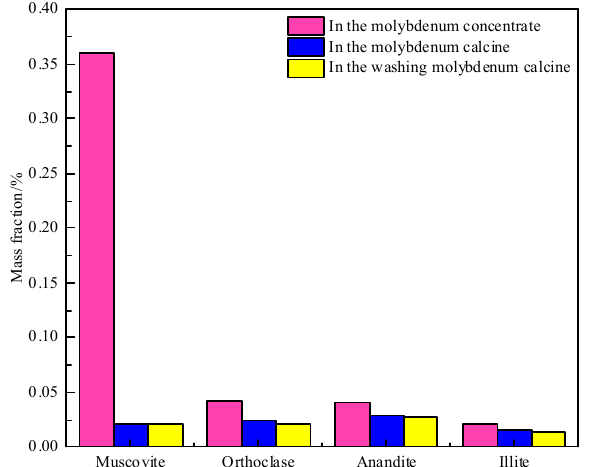
Figure 5. Mass fractions of potassium minerals during roasting-washing process.